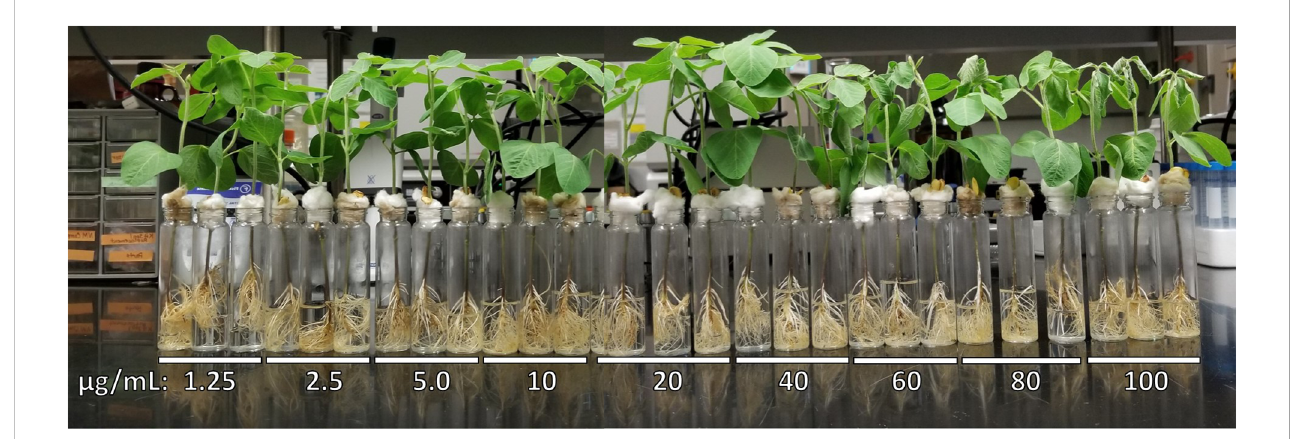
FIGURE 4 Phytotoxic responses to commercially-available mellein (0-100 µg/mL) against soybean seedlings of germplasm line DT97-4290 after 96 hours in hydroponic culture.